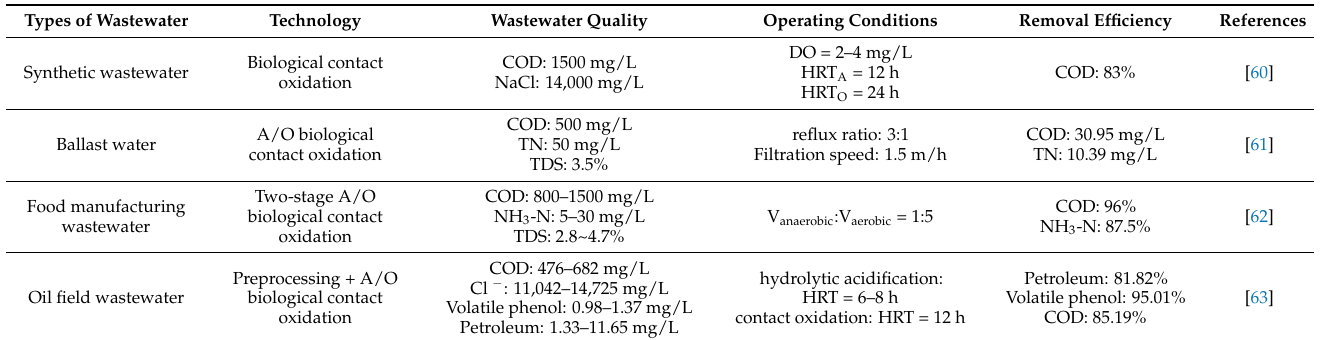
Table 6. Performance and experimental conditions of the biological contact oxidation process for the treatment of saline